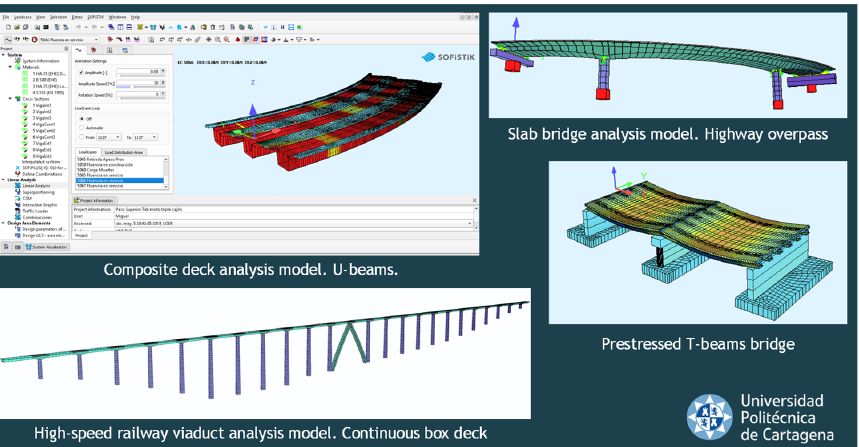
Figure 5. Bridge finite element models (Source: http://www.civil.bim.upct.es/cursos/m5-puentes- bim/, accessed on 29 July 2019).